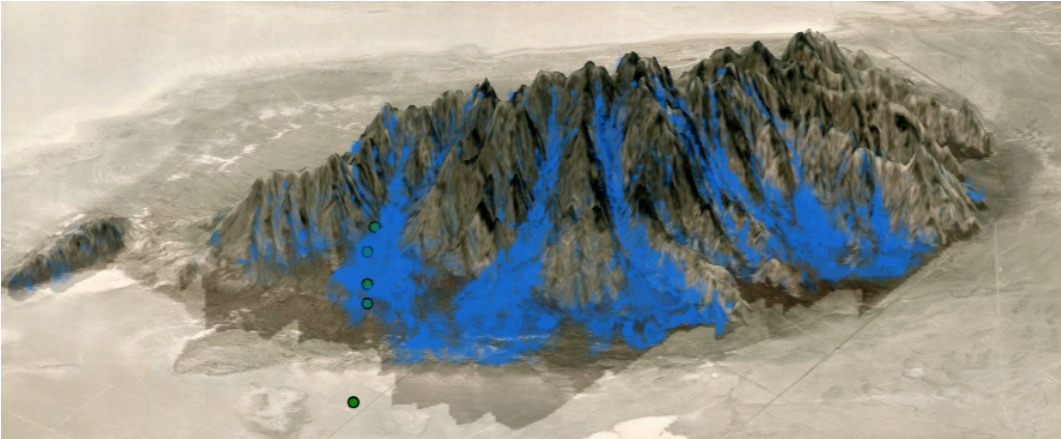
Figure 14. Downslope flow on the east side of Granite Mountain during the MATERHORN field campaign during the evening transition (18:55 MST). The WRF model is used with an immersed boundary method coupled to atmospheric physics including radiation, land-surface, and topographic shading routines. Blue isosurfaces indicate downslope velocity and topographic shading is indicated by darkening of the terrain surface. A real terrain image from Google Static Maps API is used. Observational towers are shown as green dots. An animated version of this figure is available in the online supplemental material from Arthur et al. [196]. c (cid:13) Copyright 2018 American Meteorological